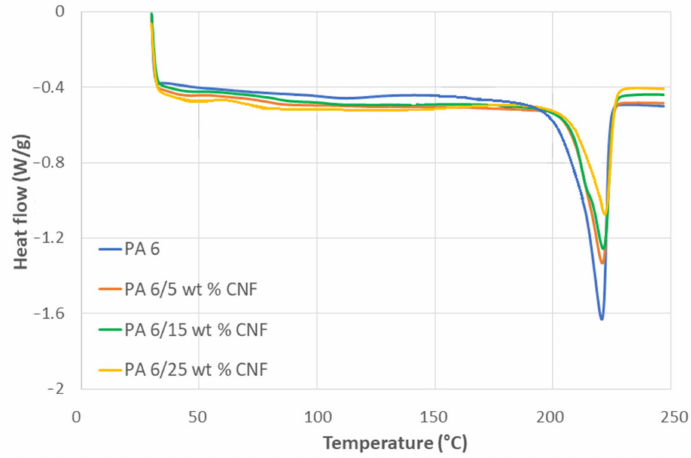
Figure 7. DSC thermogram, heating cycle for neat PA 6 and PA 6/CNF